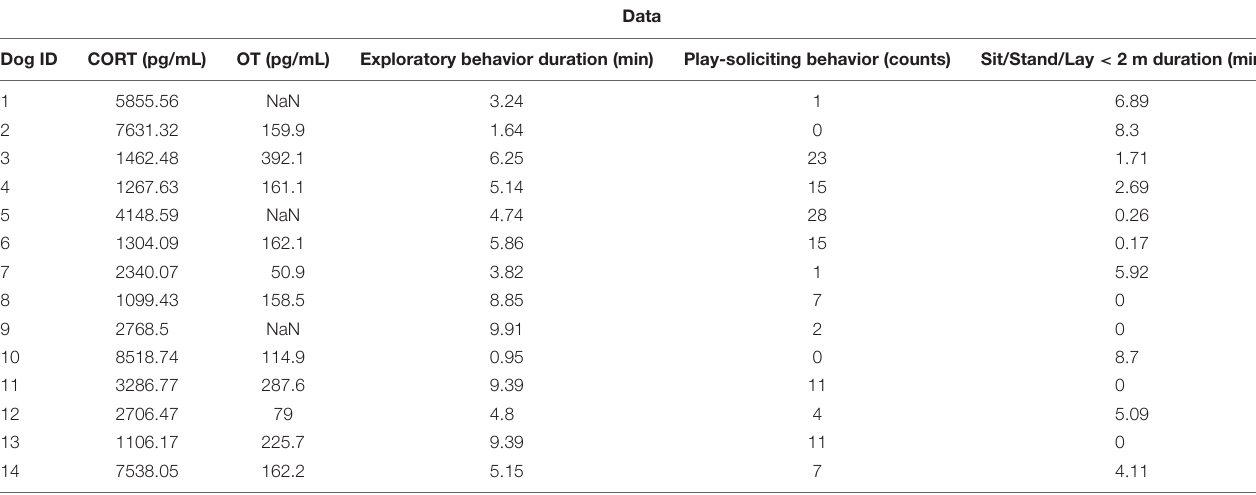
TABLE 2 | Cortisol and oxytocin levels (picograms per milliliter) and the frequency and duration for each behavior during 10 min dog spent with experimenters E1 and